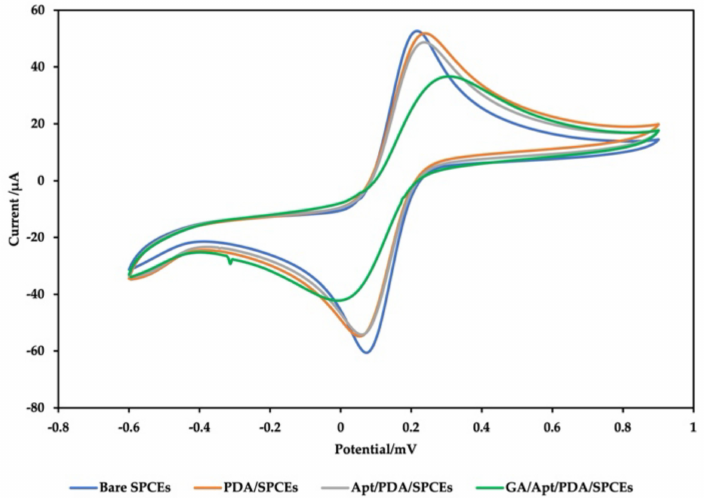
Figure 5. A Cyclic voltammograms of Bare SPCEs, PDA/SPCEs, Apt/PDA/SPCEs, GA/Apt/ PDA/SPCEs showing successful immobilization/reaction of each